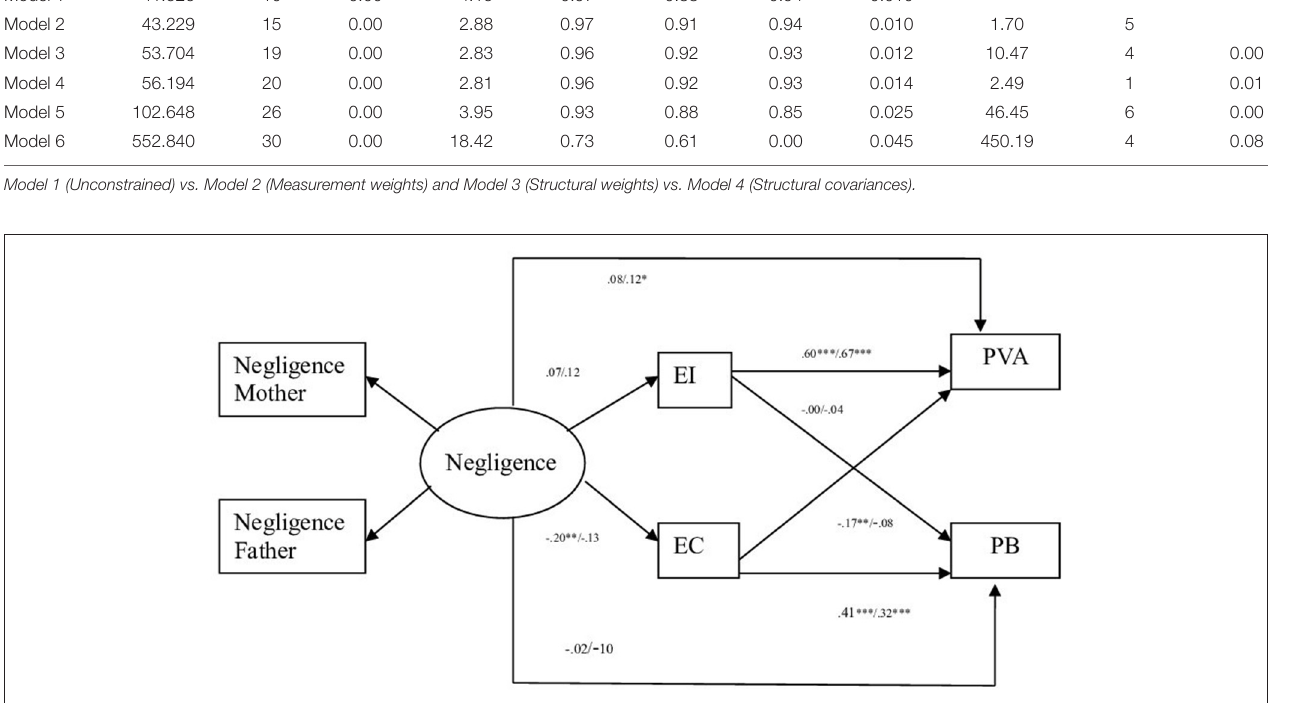
FIGURE 3 | Path standardized coefficient values of offenders and non-offenders pertinent to parental style negligence. Standardized Values. EI, Emotional Instability; EC, Empathic Concern; PVA, Physical and Verbal Aggressive Behavior; PB, Prosocial behavior. *** p < 0.001, ** p < 0.01, * p < 0.05. Non offenders left value, offenders right